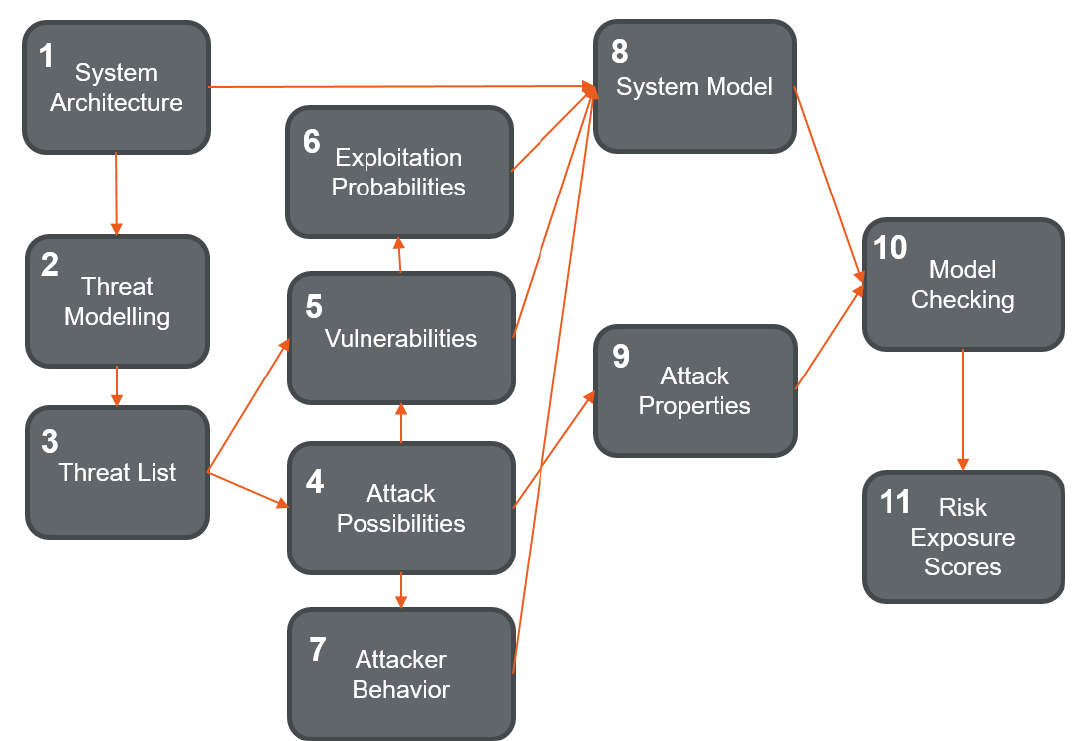
Figure 1. Risk analysis based on threat modeling and formal methods